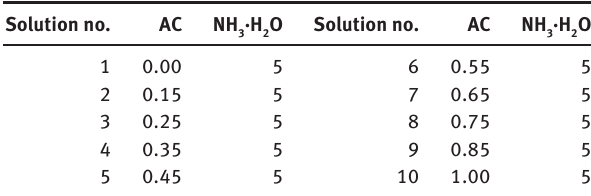
Table 2: The leaching reagent concentrations of different leaching solutions